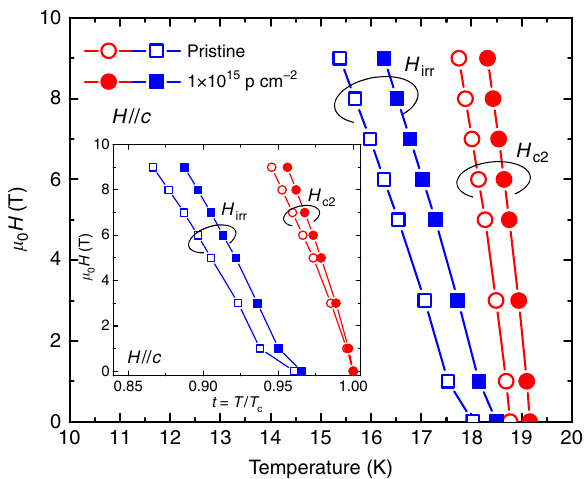
Figure 4 | Upper critical field and irreversibility field. Upper critical field H c2 ( T ) and irreversible field H irr ( T ) ( H // c ) as a function of temperature up to 9T// c for FST films before and after proton irradiation determined from Fig. 1. Inset: normalized temperature ( t ¼ T/T c ) dependence of H c2 and H irr for the same field orientation. Error bars are of a size smaller than the data points.